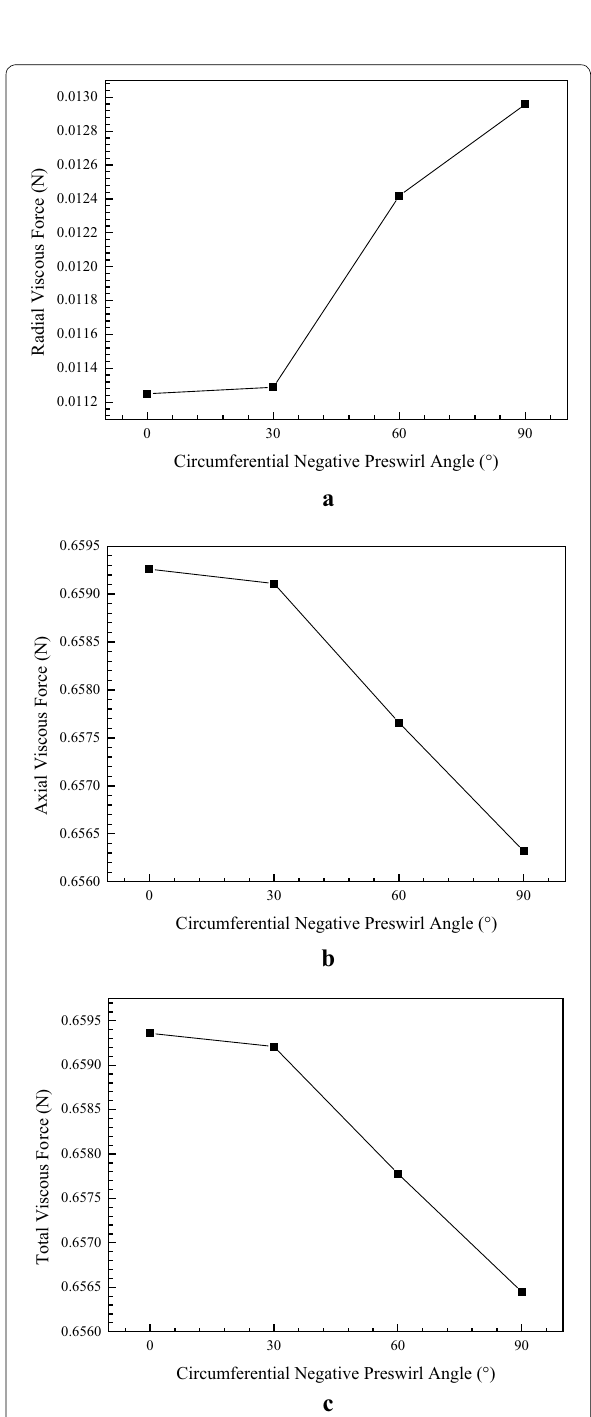
Figure 16 Viscous forces versus circumferential negative pre-swirl angle: a radial viscous force; b axial viscous force; c total viscous